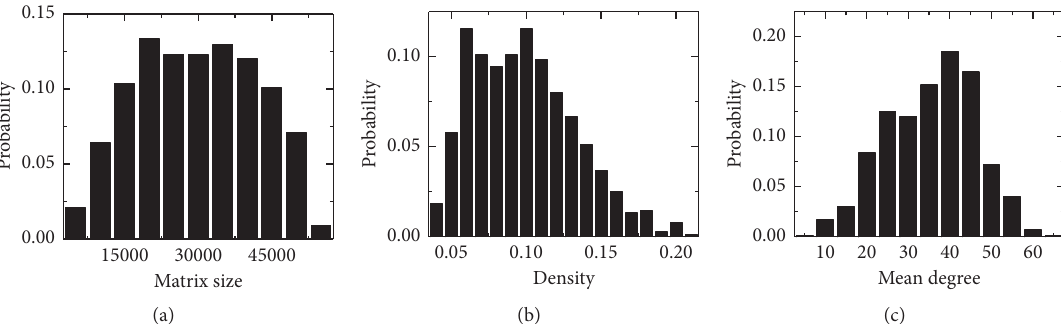
Figure 2: The relevant characteristics of the multiplex world trade network. (a) The distribution of the matrix size corresponding to the multiplex world trade network. The matrix size of each network is that the number of rows multiplies the number of columns. (b) The distribution of the network density (the ratio between the number of ones and matrix size). (c) The distribution of network average degree (i.e., the mean of in-degree and